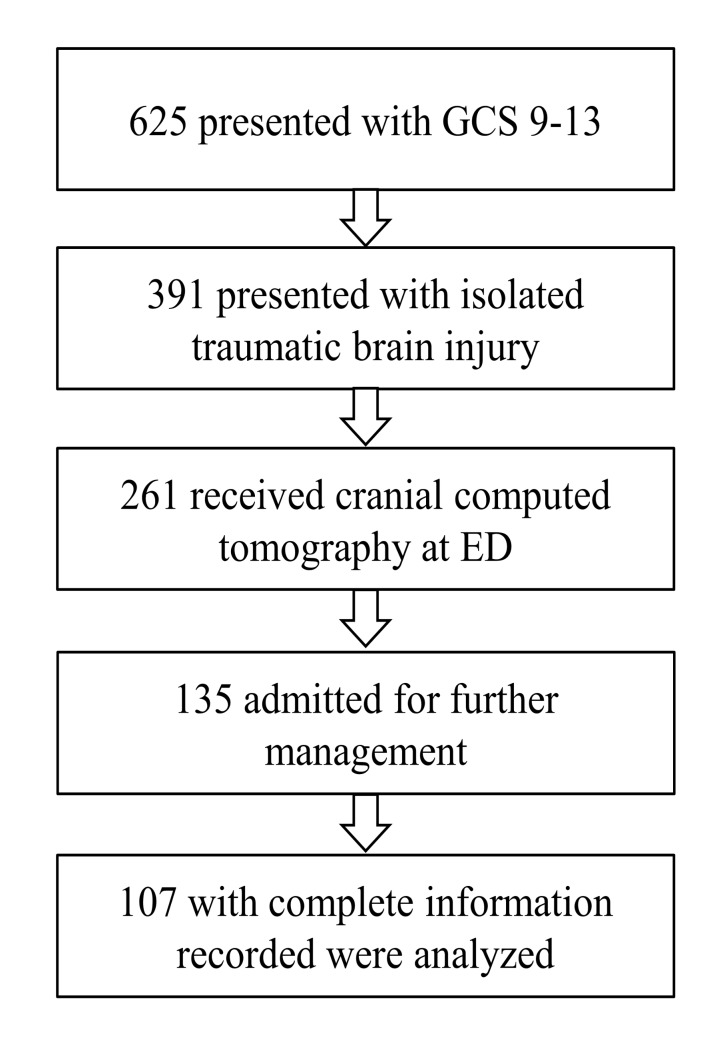
Algorithm for study case selection.